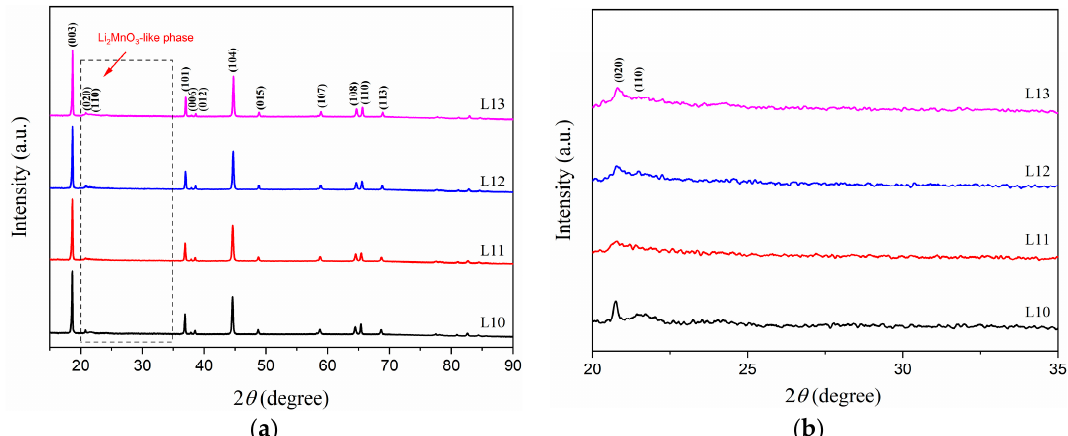
Figure 2. ( a ) XRD patterns of samples L10–L13; ( b ) Magnified rectangle region in ( a ): superlattice peaks of C2/m Li 2 MnO 3 in the 2 θ range of 20–25°.